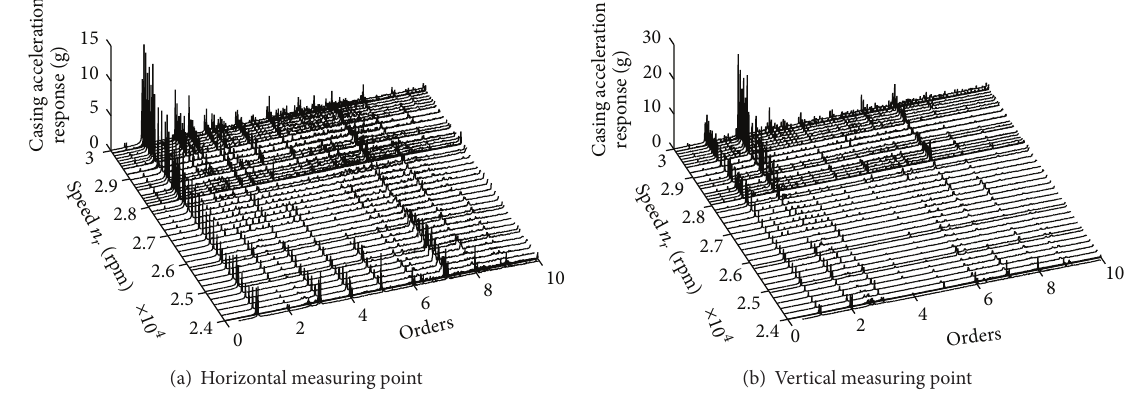
Figure 18: Cascade plot of casing acceleration response at different measuring